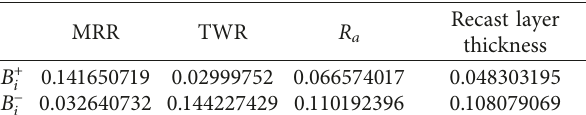
Table 17: Determination of the ideal ( B +